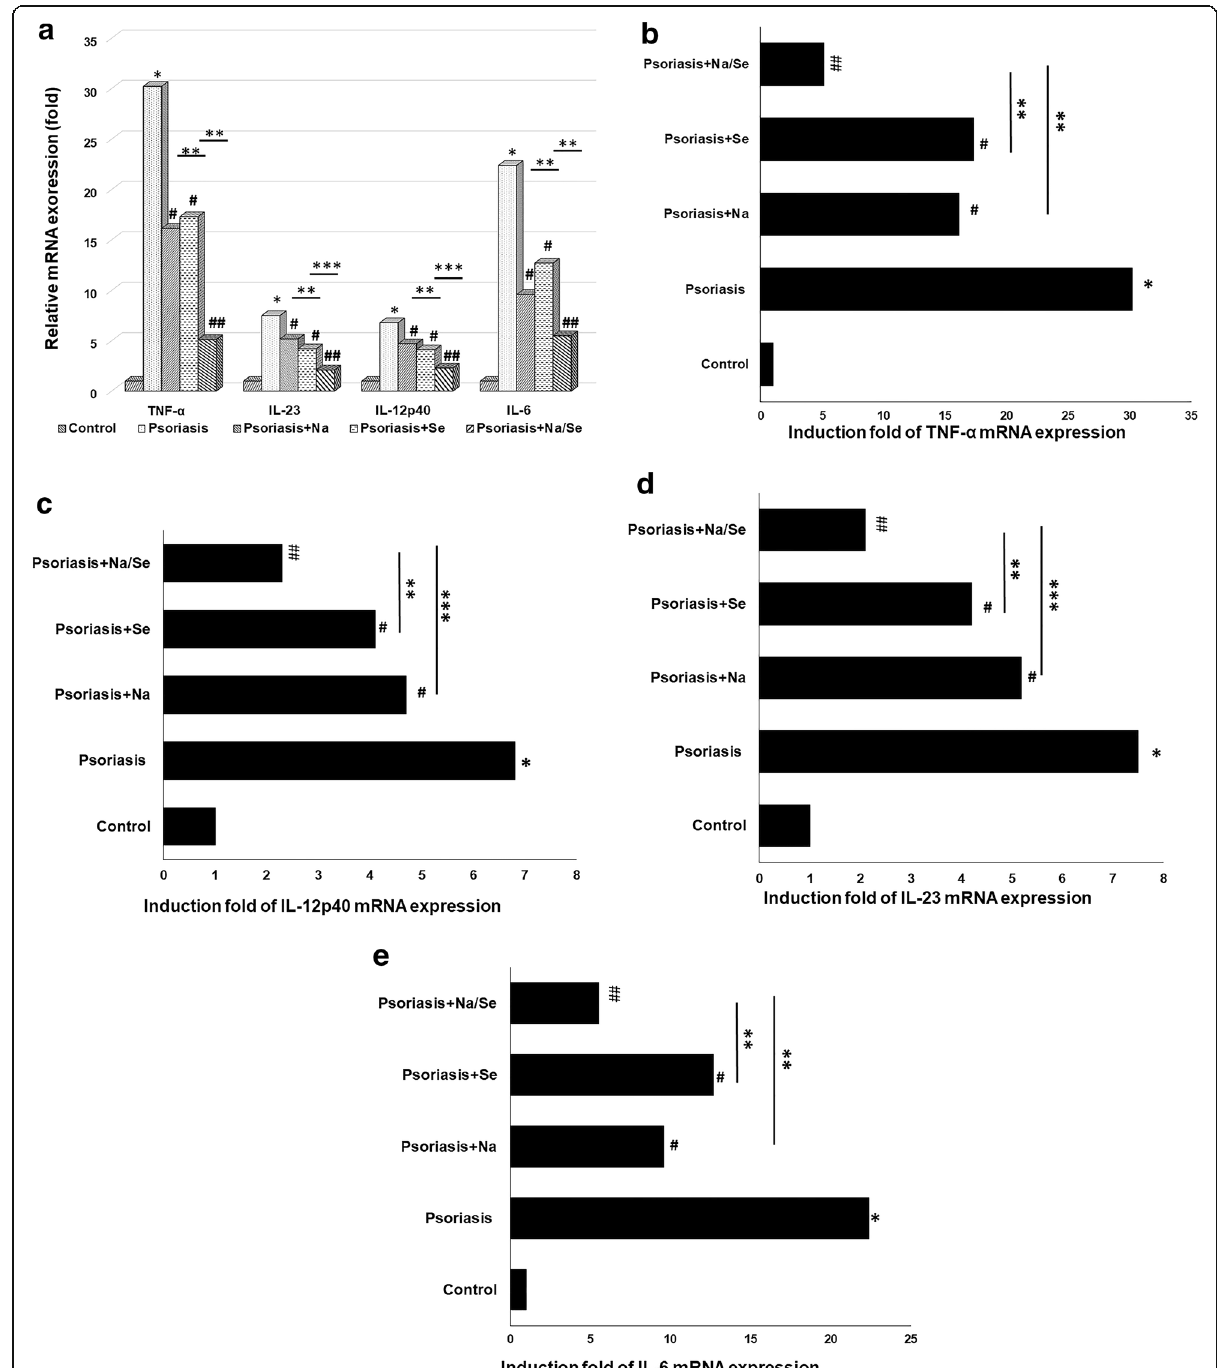
Fig. 3 The mRNA expressions levels of TNF- α , IL-6, IL-12p40 and IL-23 genes in hPBMCs obtained from psoriasis patients and healthy control treated with 20 μ g/mL Na, 100 μ g/mL Se and Na/Se combination (20/100 μ g/mL at the ratio of 1:1 (v:v). The data showed the effect of naringin (Na) and sericin (Se) on hPBMCs-induced pro-inflammatory cytokine mRNA expression in hPBMCs ( a ). The patterns of induction fold of mRNA expression of all cytokines generally correlated with mRNA expression levels ( b - e ). *P < 0.001 vs. untreated control hPBMCs from healthy subjects by Mann-Whitney U test. #P < 0.05 and ## P < 0.001 vs. untreated pPBMCs from psoriasis patients by Mann-Whitney U test . ** P < 0.05 and *** P < 0.001 vs. treated hPBMC with Na/Se from psoriasis patients by Mann-Whitney U